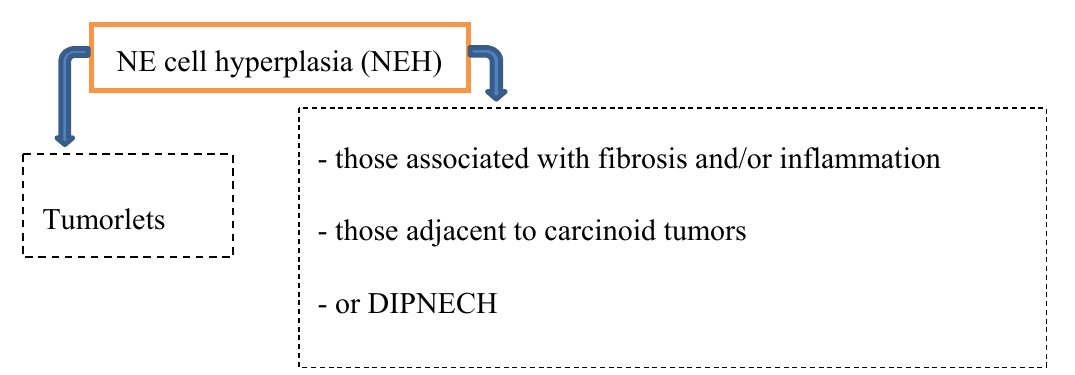
Figure 1. Precursor